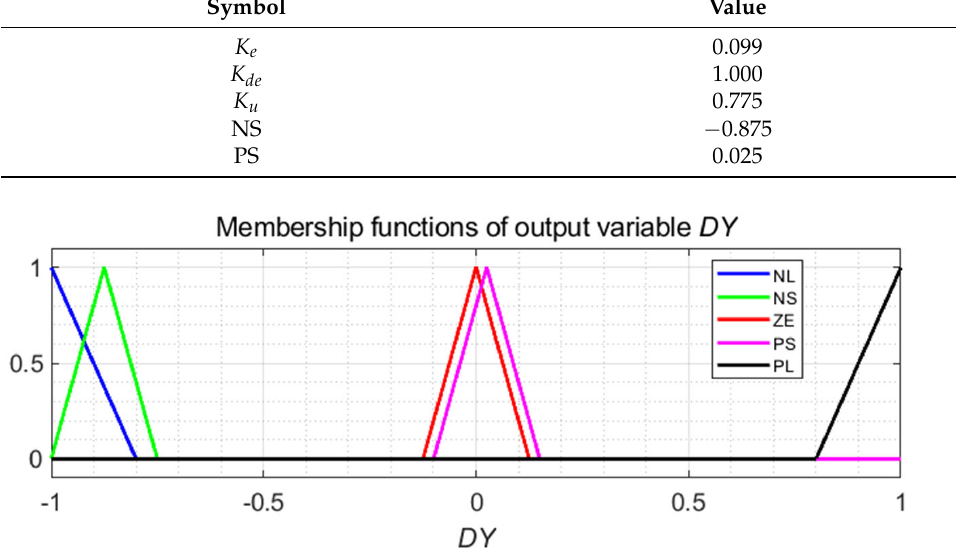
Figure 6. Position fuzzy PD logic controller membership functions of output variable DY after optimization with objective functions OF1 (N: negative, ZE: zero, P: positive, L: large, S: small).